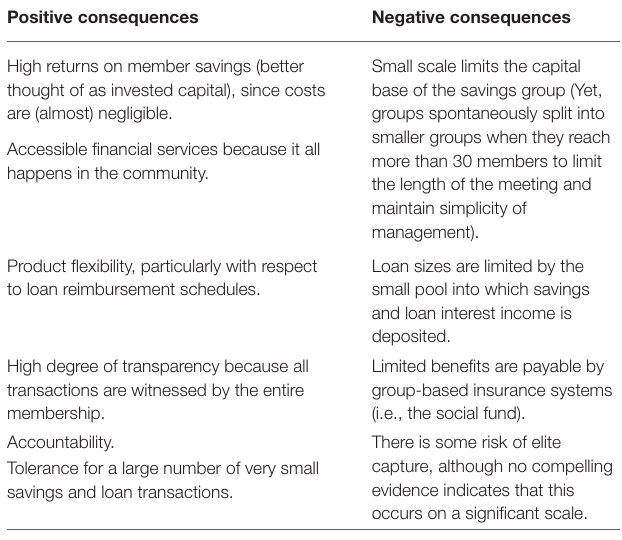
TABLE 2 | Financial implications of the savings group model. Positive consequences Negative